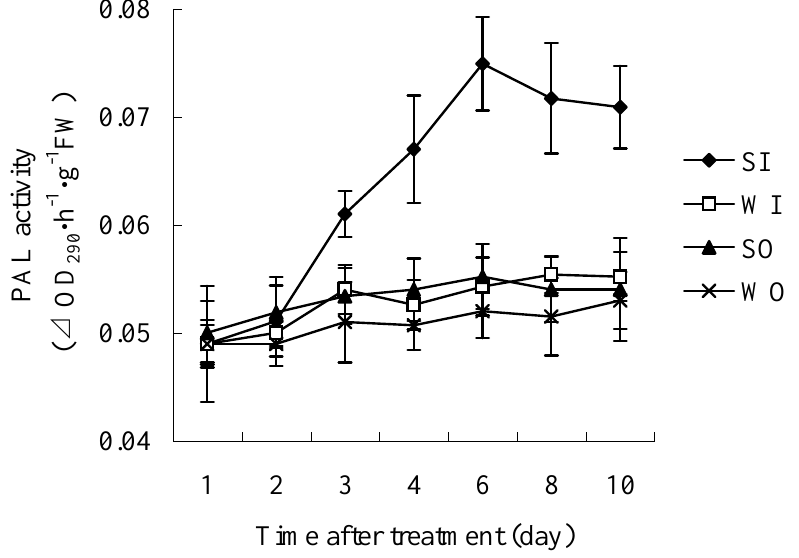
Figure 3. PAL activity in pumpkin leaves upon osthol application and/or S. fuliginea inoculation. Non-osthol-treated and non-inoculated plants (WO), plants treated with osthol and non-inoculated (SO), non-osthol-treated plant inoculated (WI) and osthol- treated plant inoculated with S. fuliginea (SI). Each value is the mean ± S.E. for